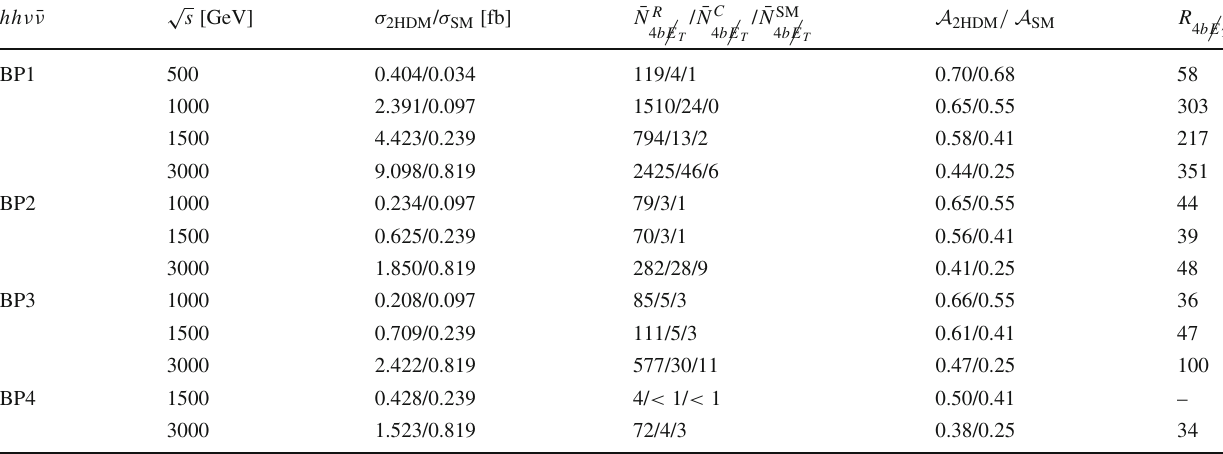
√ Table 6 R s . Also shown are total cross sections, σ , event numbers, ¯ N , and acceptances, A , in the 2HDM and the for the BPs at all relevant 4 b (cid:3) E T SM, as defined in the text. “–” indicates values that cannot be evaluated due to a too small number of events hh ν ¯